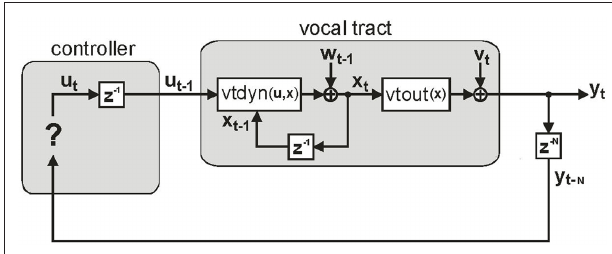
Figure 2 | The control problem in speech motor control. The figure shows a snapshot at time t , when the vocal tract has produced output y response to the previously applied control u